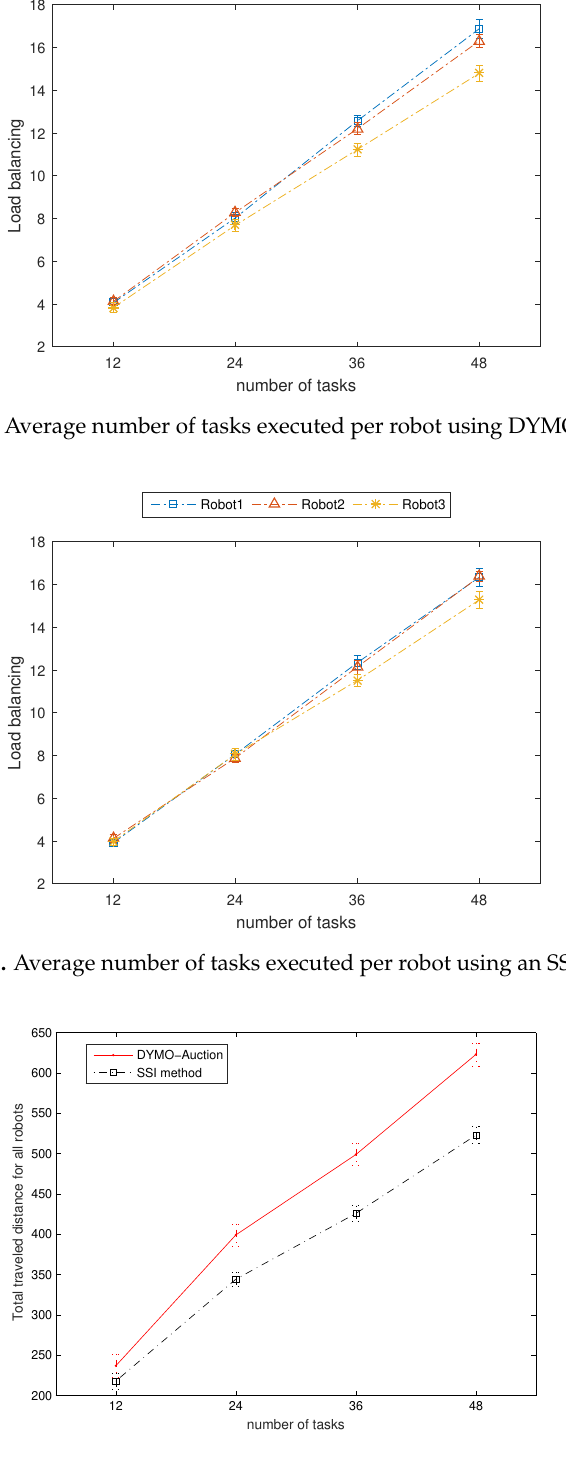
Figure 12. Total traveled distance